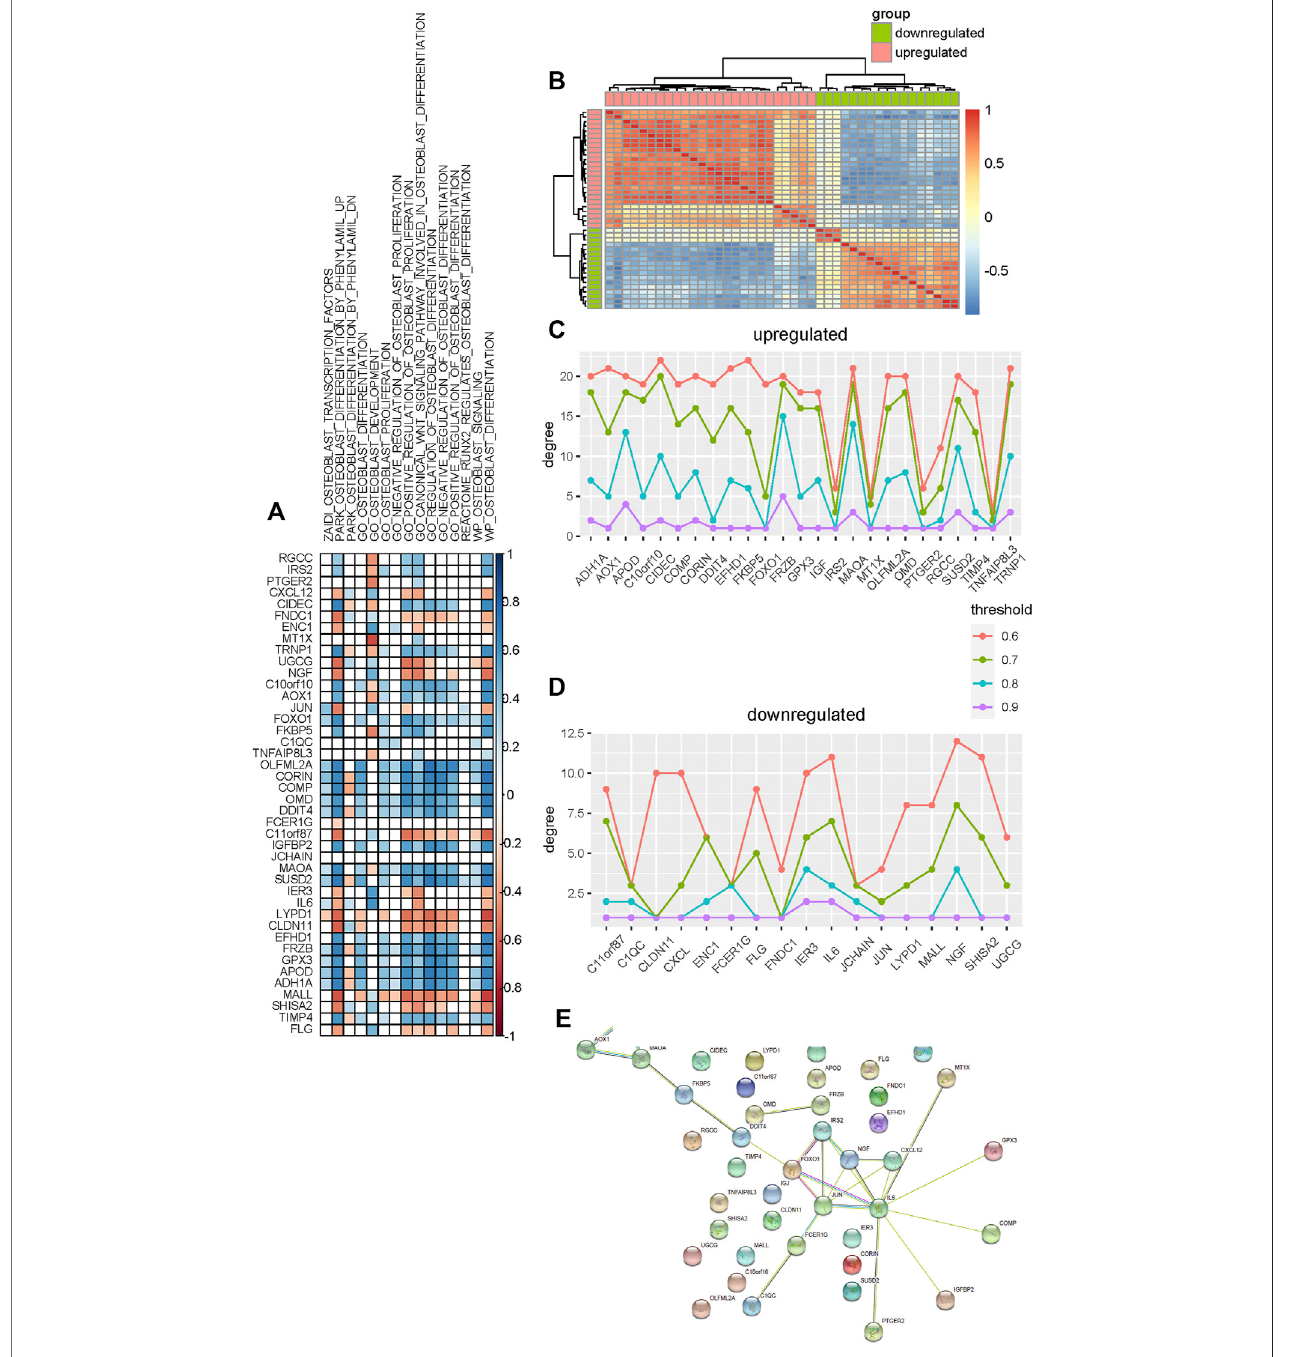
FIGURE 4 | Selection of candidate genes that are signi fi cantly associated with the osteogenic process. (A) Association analysis between these differentially expressed genes and osteoblast-related pathways. Blue and red colors indicate the positive and negative correlations, respectively. Blank indicates that there is no signi fi cance. (B) Heat map shows the co-expression pattern of these differentially expressed genes. Association is evaluated using the Pearson correlation coef fi cient. (C,D) Degree of upregulated and downregulated genes in the co-expression network constructed using different thresholds. (E) Protein – protein interaction network of these differentially expressed genes is